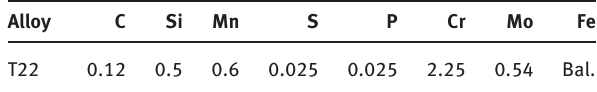
Table 1: Chemical composition of the alloys (wt.%). Alloy